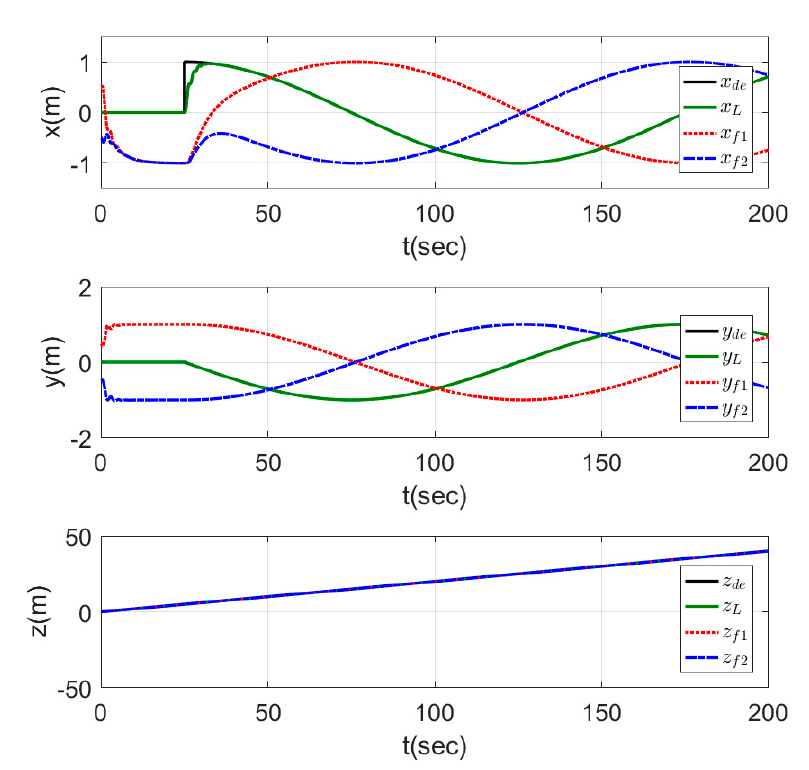
Figure 17. Time response of leader orientation-based formation tracking a helical trajectory.